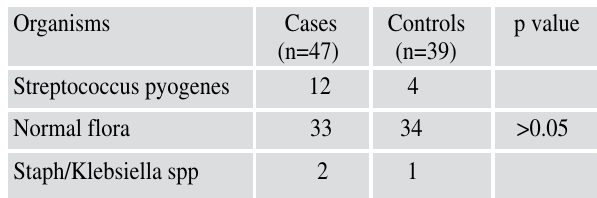
Table IV: Comparison of throat swab culture